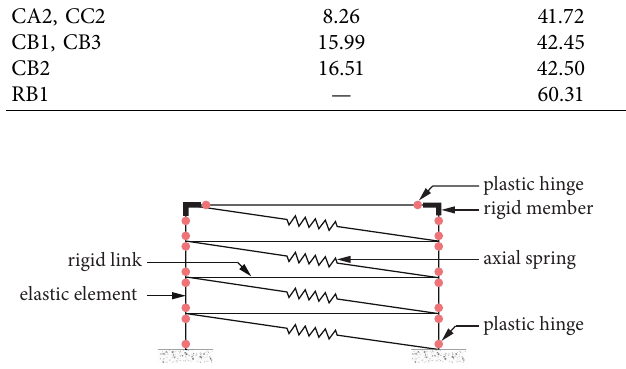
Figure 6: Model of multispring masonry inflled